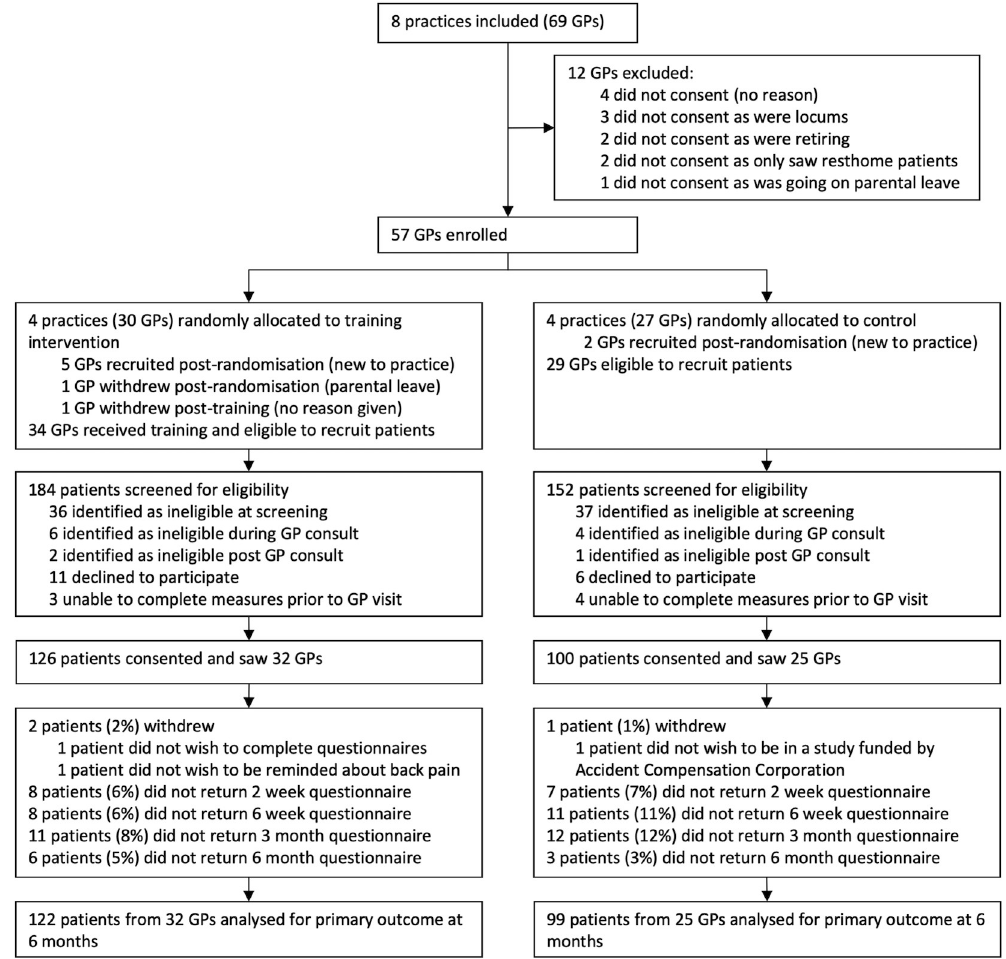
Fig 2. Trial profile. Supplementary data available in S1 Appendix S4 (p 3). GP, general